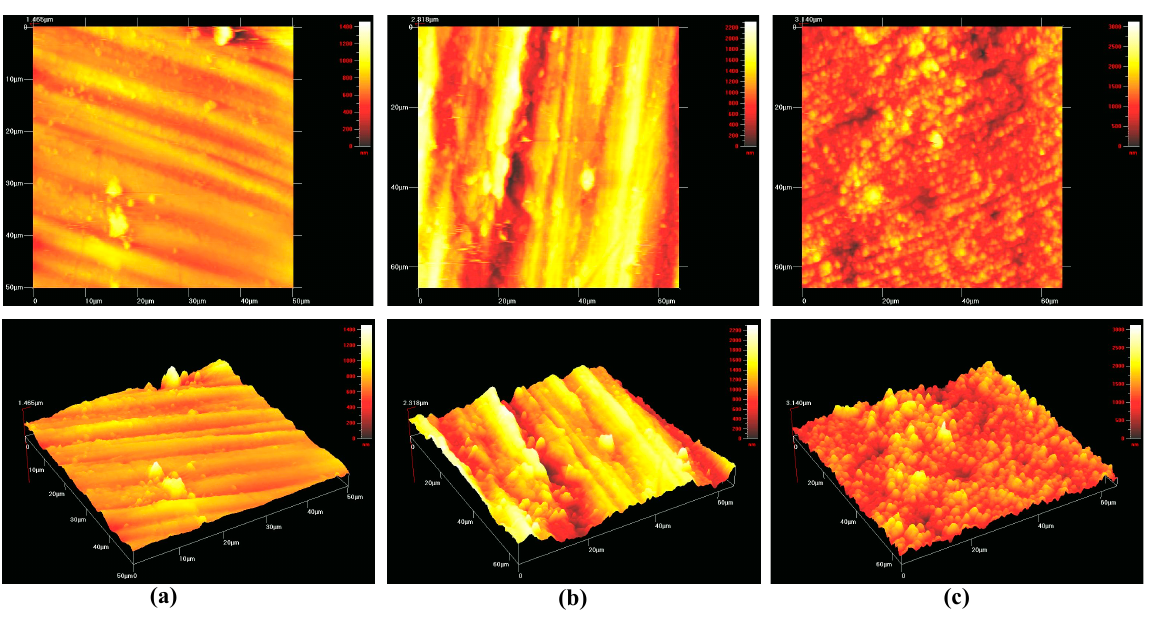
Figure 3. Surface topography of each material: ( a ) commercially pure titanium; ( b ) yttria-stablized zirconia; and ( c ) aluminium-toughened zirconia. Scale bar ( a ) 0–1400 nm; ( b ) 0–2200 nm; and ( c ) 0–3000 nm.